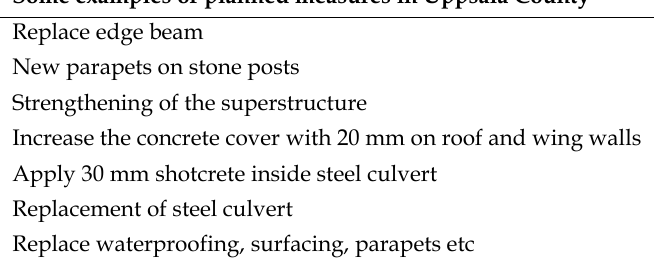
Table 2. Examples of planned measures during the contract period. Some examples of planned measures in Uppsala County